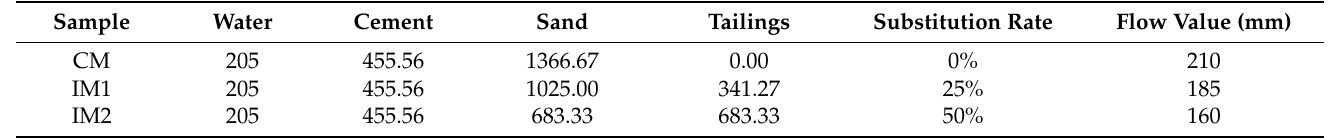
Table 1. Mix ratio of cement mortar with different compositions, kg/m 3